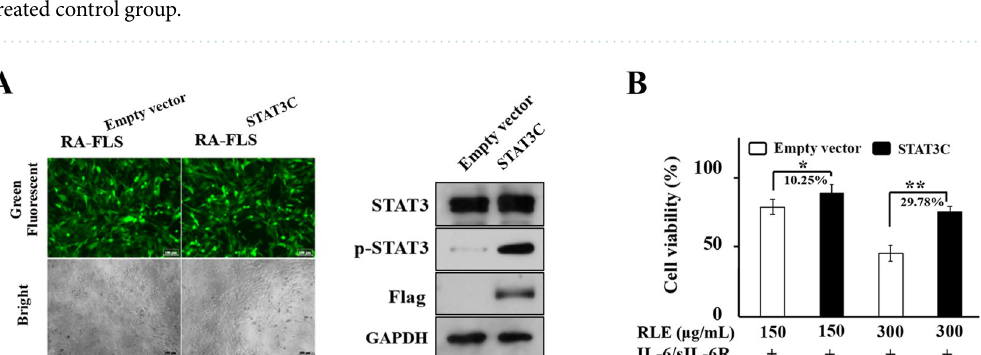
Figure 5. RLE inhibited STAT3 signaling in RA-FLS. ( A ) IL-6/sIL-6R time-dependently induced phosphorylation of STAT3 in RA-FLS. Synoviocytes were treated with IL-6/sIL-6R for indicated durations. ( B ) RLE suppressed the phosphorylation of STAT3 and JAK2 in IL-6/sIL-6R-stimulated synoviocytes. Cells were pre-treated with indicated concentrations of RLE for 1 h and then treated with or without IL-6/sIL-6R for 40 min. ( C ) RLE suppressed IL-6/sIL-6R-induced STAT3 nuclear localization in synoviocytes. Cells were treated as in ( B ). ( D ) RLE lowered protein levels of Bcl-2 and Mcl-1 in IL-6/sIL-6R-stimulated synoviocytes. Synoviocytes were pre-treated with indicated concentrations of RLE for 1 h and then treated with or without IL-6/sIL-6R for 24 h. In ( A – D ), protein levels were examined using immunoblotting. Representative blots are shown in left panels. Protein levels relative to loading controls were analyzed using ImageJ software, and are shown in right panels (n = 3). In ( A , B , D ), GAPDH served as the loading control. In ( B ), Lamin B1 and GAPDH served as loading controls of nuclear and cytoplasmic extracts, respectively. In ( A ), ## P < 0.01 vs. 0-min time point group. In ( B – D ), * P < 0.05, ** P < 0.01 vs. IL-6/IL-6R-only-treated group. # P < 0.05, ## P < 0.01 vs. vehicle- treated control group.